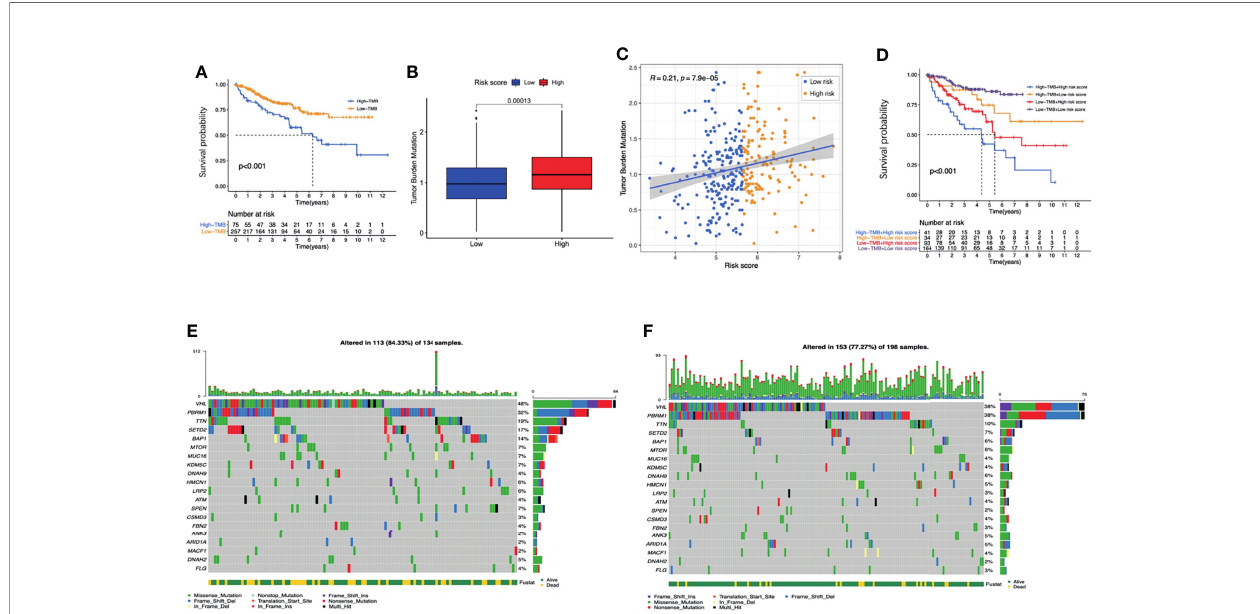
FIGURE 11 | The analysis of TMB. (A) K-M survival analysis of the TMB score. (B) The TMB scores between high-risk and low-risk groups. (C) The correlations between the TMB score and risk score. (D) K-M survival analysis of the risk score combined with the TMB score. The waterfall graphs of most frequently mutated genes in high-risk group (E) and in low-risk group (F) . TMB, tumor mutation burden; K-M, Kaplan –